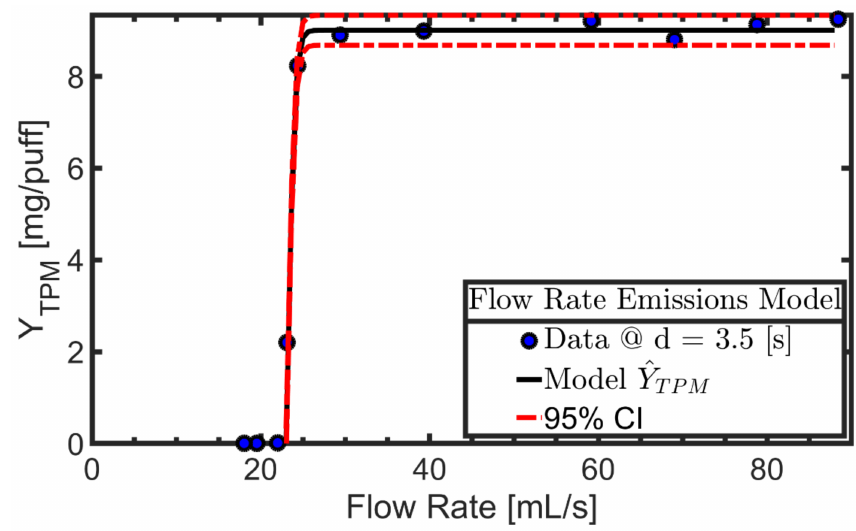
Figure 1. Product EC14-01. TPM yield per puff observed during “activation flow rate” screening trials conducted with nominal puff duration of 3.5 [s] and puff flow rate varying from 23 to 88 [mL/s]. The nonlinear regression emissions model (solid line) and 95% confidence interval (dashed line) are illustrated.